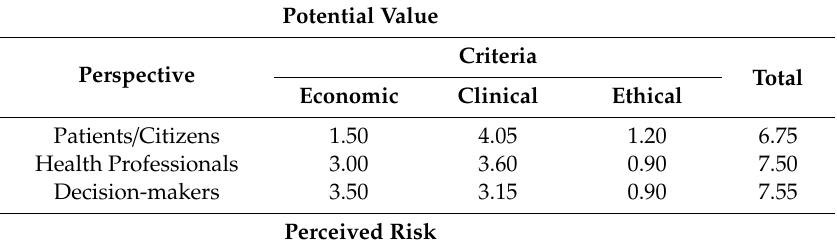
Table 4. Contact tracking app, scores for each perspective and criteria.